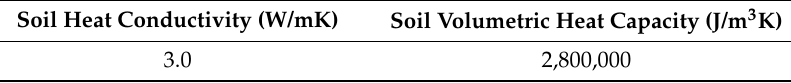
Table 2. Soil thermal parameter values.